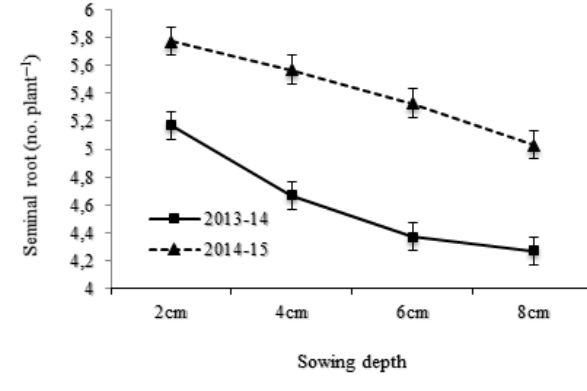
Figure 3: Plant height as affected by sowing depth at different days after sowing of wheat (average of 2 years). Mean (±SD) was calculated from three replicates for each treatment and significantly different at P ≤ 0.05 (LSD test).